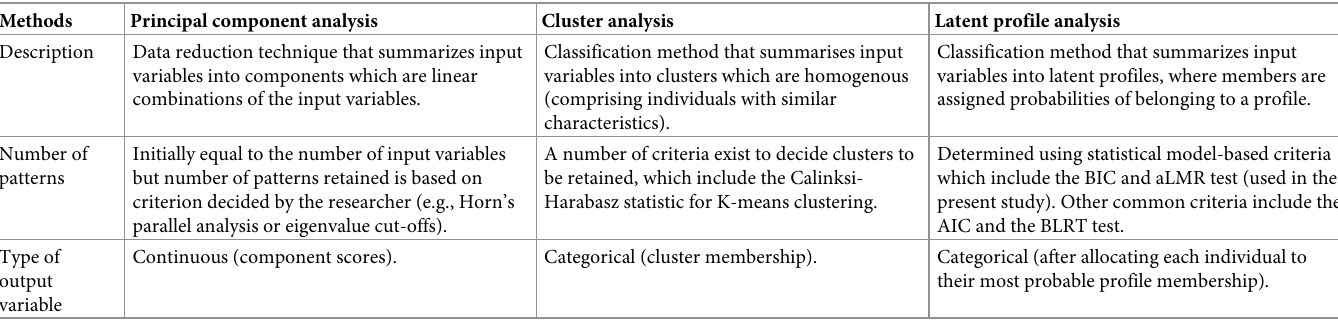
Table 1. Brief summary of pattern derivation